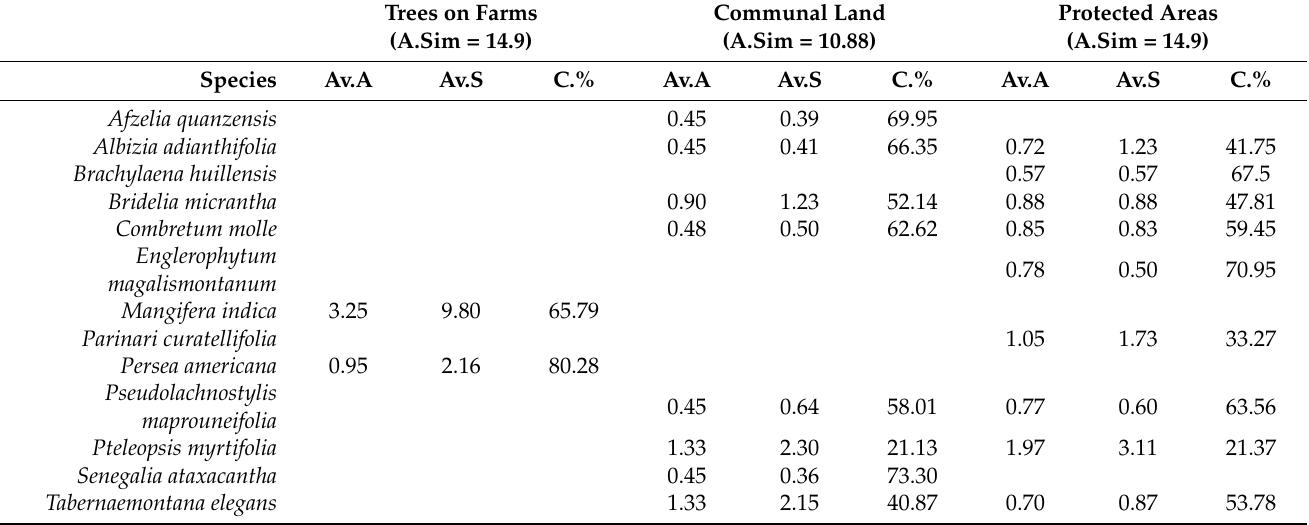
Table 6. Similarity Percentages (SIMPER) analysis of tree species abundance similarity. Trees on Farms (A.Sim =